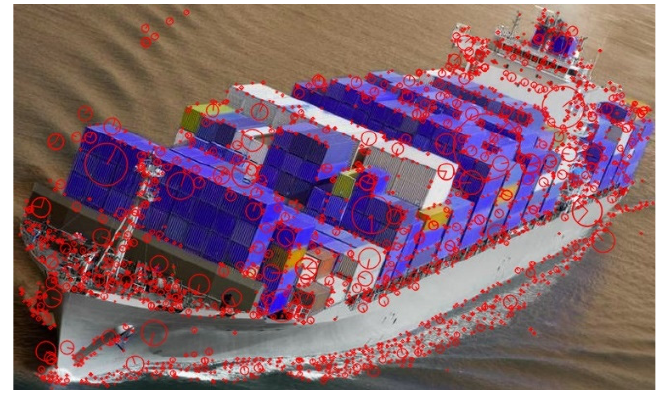
Figure 3. SIFT feature on key point descriptors of ship.